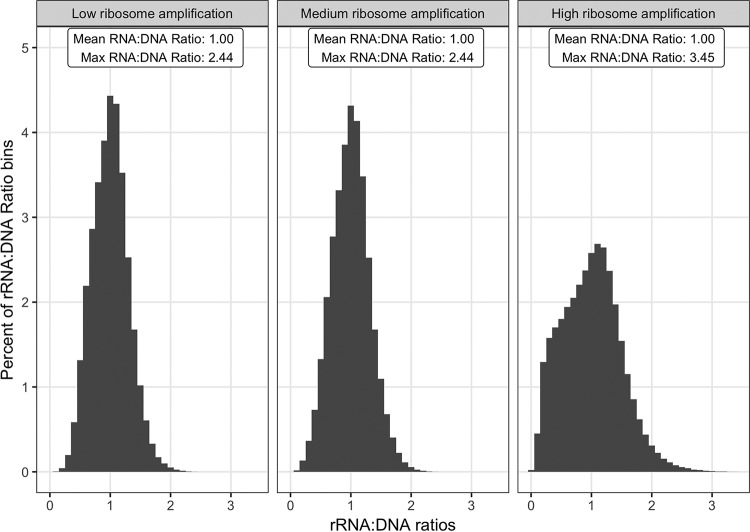
Effects of rRNA amplification models on rRNA/DNA ratios. Shown are histograms of rRNA/DNA ratios for each population generated from the simulations. The simulations represent the low, medium, and high rRNA amplification models run under the lognormal σ1 community structure model. Qualitatively similar data were obtained with the σ0 and σ2 community structure models, so the data are not shown. Each histogram represents the cumulative data of 100 independent runs of a simulation.